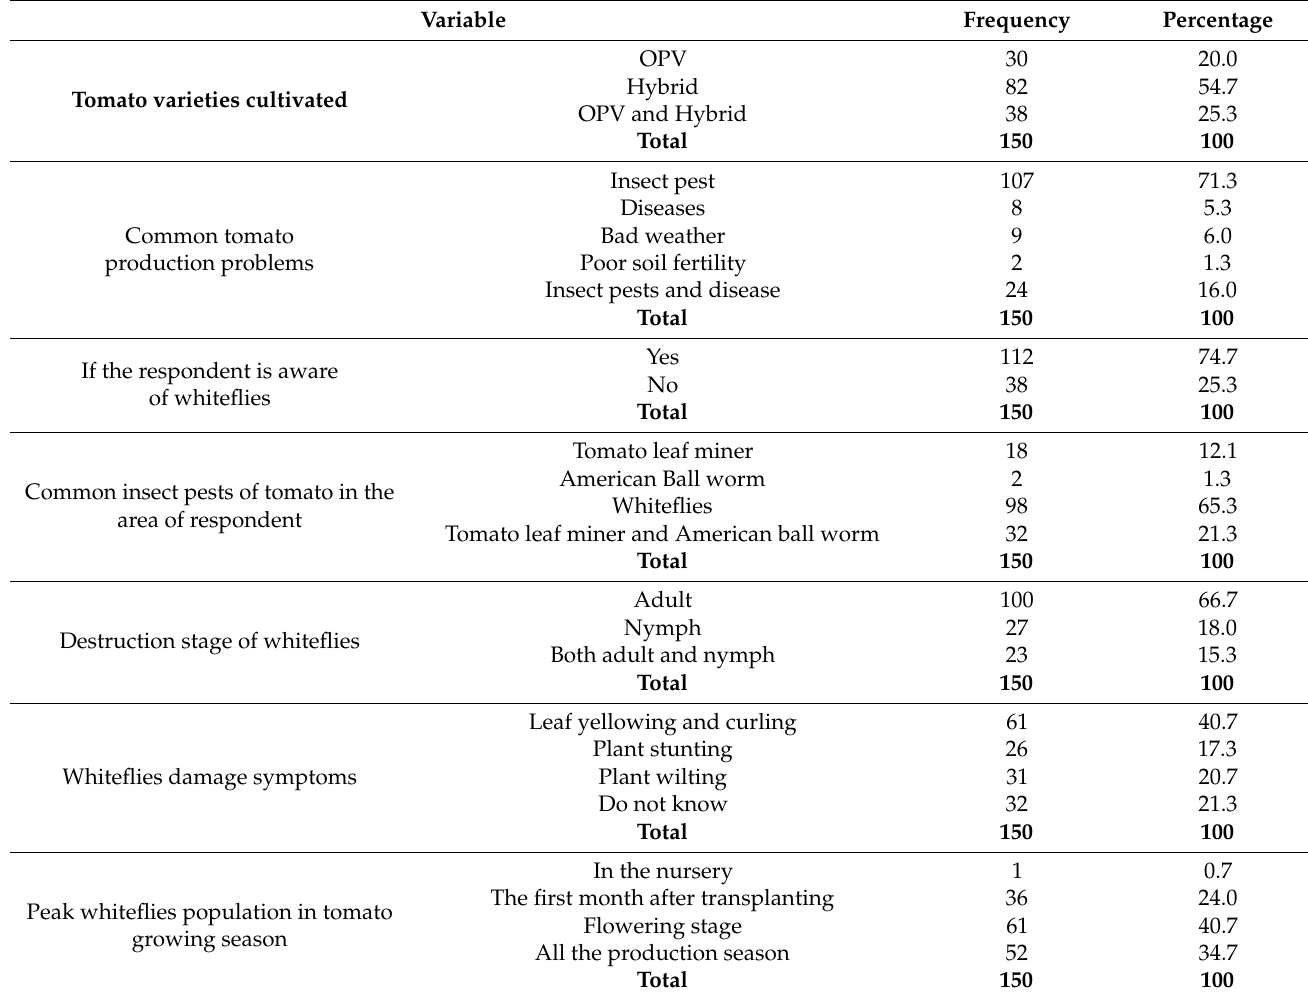
Table 3. Farmers’ knowledge and perception on various aspects of tomato pests in the study